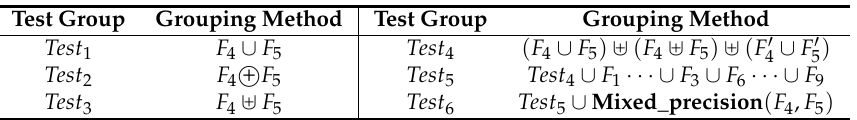
Table 4. Test grouping